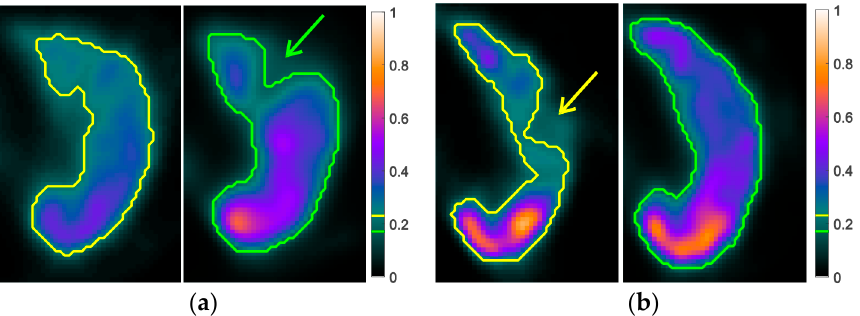
Figure 3. Segmented SPECT ventilation (left) and perfusion (right) images of a left lung. The contour of the segmentation is drawn in yellow (ventilation) and green (perfusion) in the images and the color bar. ( a ) Patient with CTEPH and typical perfusion defects (arrow). ( b ) Patient with a respiratory pathology and typical ventilation defect (arrow).